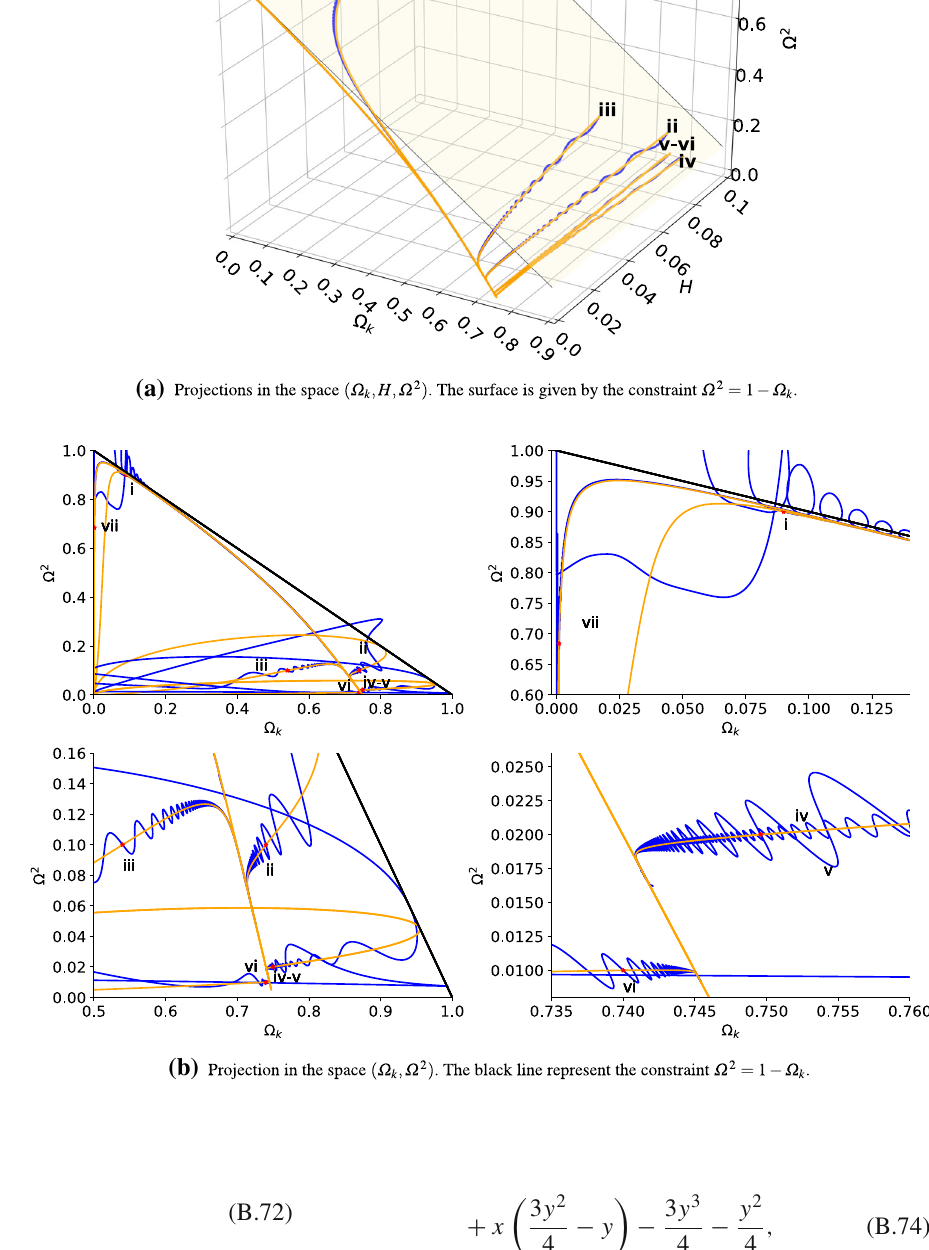
Fig. 18 Some solutions of the full system (46) (blue) and time-averaged system (78) (orange) for the LRS Bianchi III metric when γ = 4 / 3, in the projection Σ = 0. We have used for both systems initial data sets presented in the Table